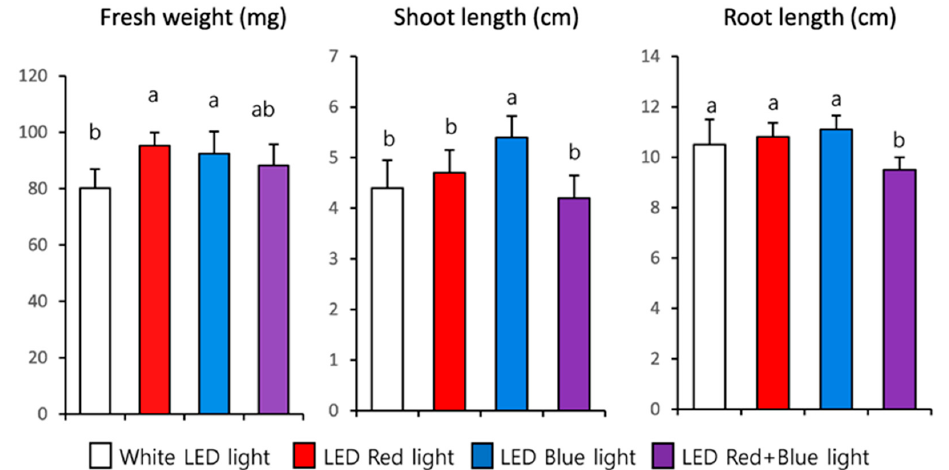
Figure 2. Effect of white, blue, red, and red + blue LED lights on the growth of 10 days for kohlrabi sprouts. Mean values marked with different alphabetical letters were significantly different ( p < 0.05, ANOVA, DMRT).